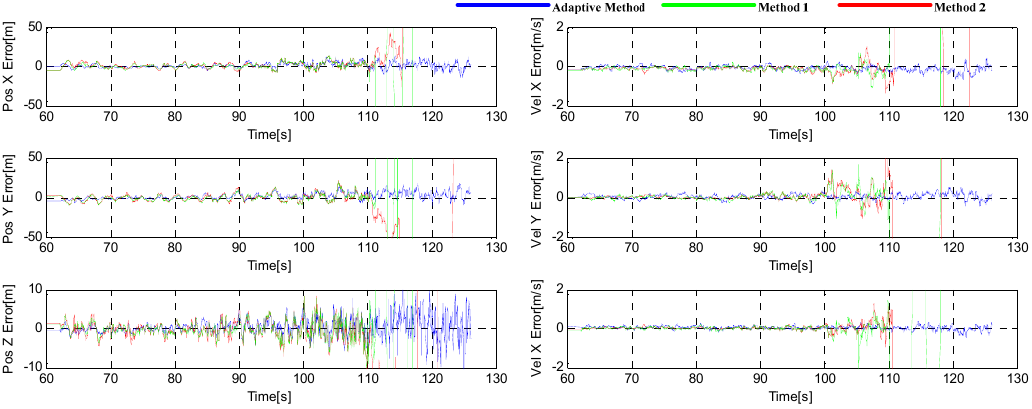
Figure 20. Position ( left ) and velocity ( right ) errors during the simulation in Trajectory 1.